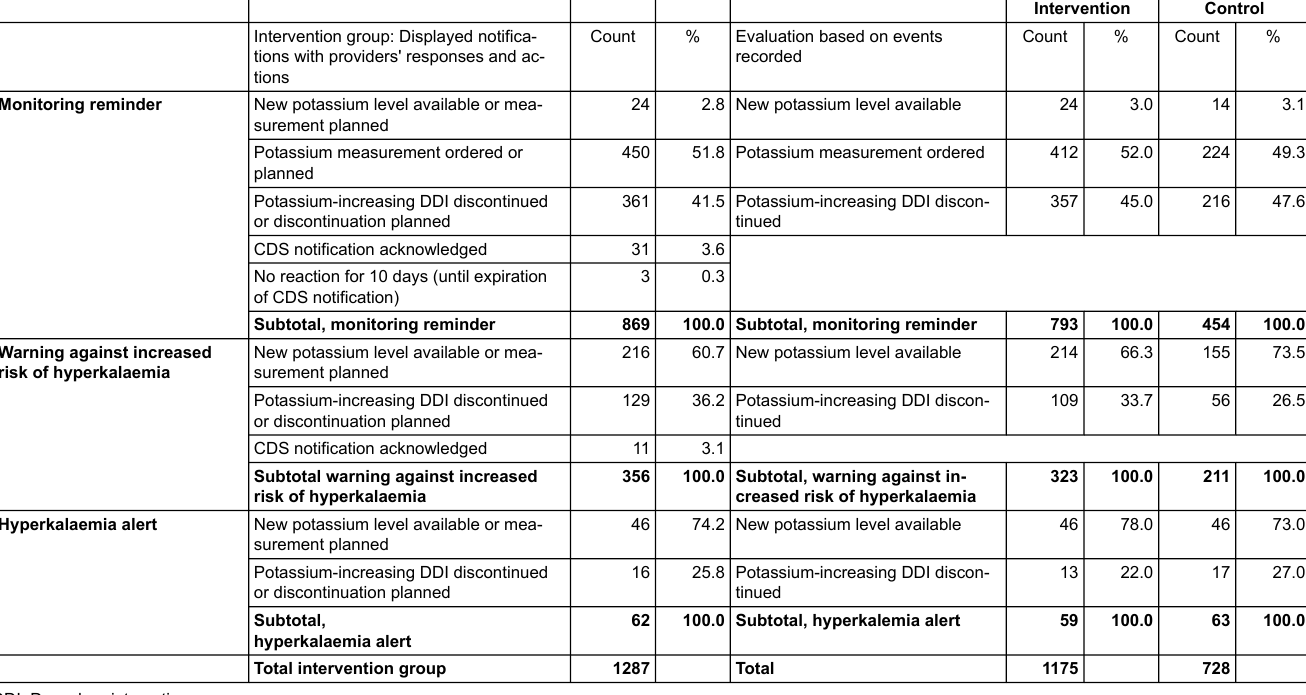
Table 2: Events and providers’ actions during the period of displaying and suppressing the notifications in the intervention and control group, respectively. Intervention Control Intervention group: Displayed notifica- Count % Evaluation based on events Count % Count tions with providers' responses and ac- recorded